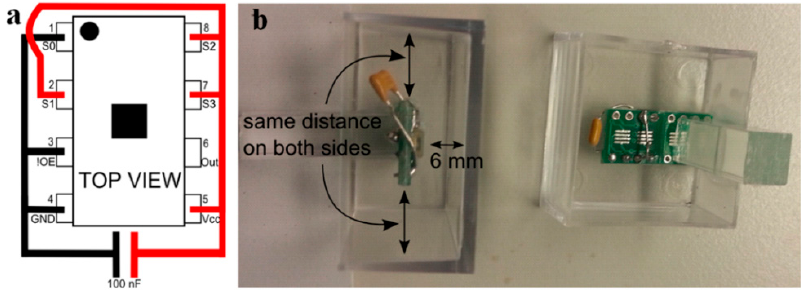
Figure 5. ( a ) Electrical schema of the light sensor; ( b ) Position of the sensor in transparent polyester